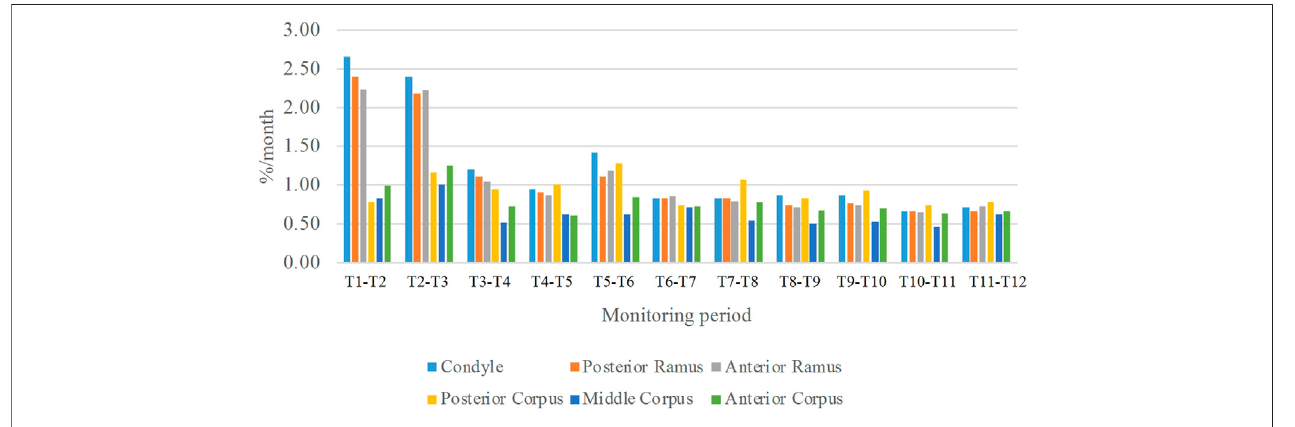
FIGURE 9 | Means of the monthly average growth rates over each of the six regions of the mandible over the monitoring period of one year. ( n = 8)